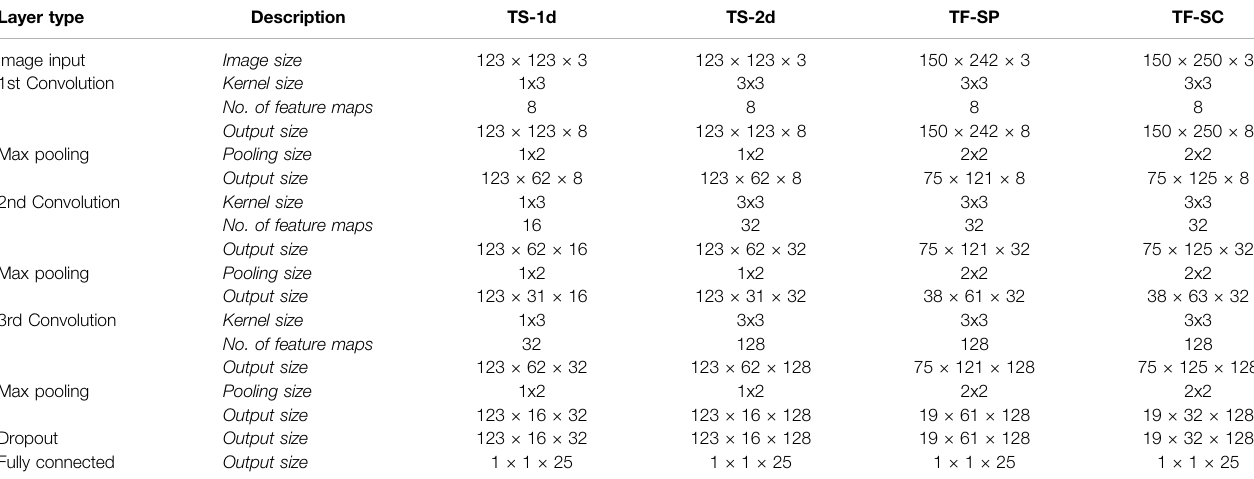
TABLE 3 | Architecture details for the four trained